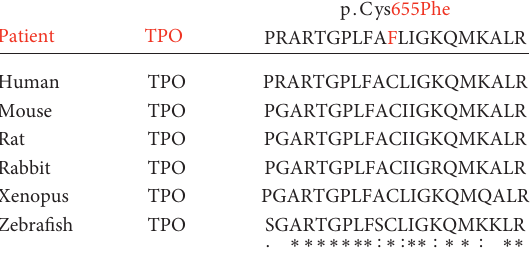
Figure 2: Comparison of amino acid sequences with various mammalian species amino acid sequences containing the novel mutations was compared with those in other mammalian species. ClustalW calculates the best match for selected sequences and lines them up so that identities and differences can be observed. The arrow indicates the position of the amino acid substitution Cys655Phe. The asterisks show perfectly preserved amino acids. The colons show high homology. The dots show low homology. The amino acid sequences are based on Ensembl, which is a genome browser for vertebrate genomes, and NCBI, which houses a series of databases relevant to biotechnology and biomedicine and is an important resource for bioinformatics tools and services. Human TPO (ENST00000329066.8), mouse TPO (ENSMUST00000021005.14), rat TPO (ENSRNOT00000006526.3), rabbit TPO (ENSOCUT00000016422.3), xenopus (tropical clawed flag) TPO (ENSXETT00000002202.1), and zebrafish (Danio rerio ) TPO